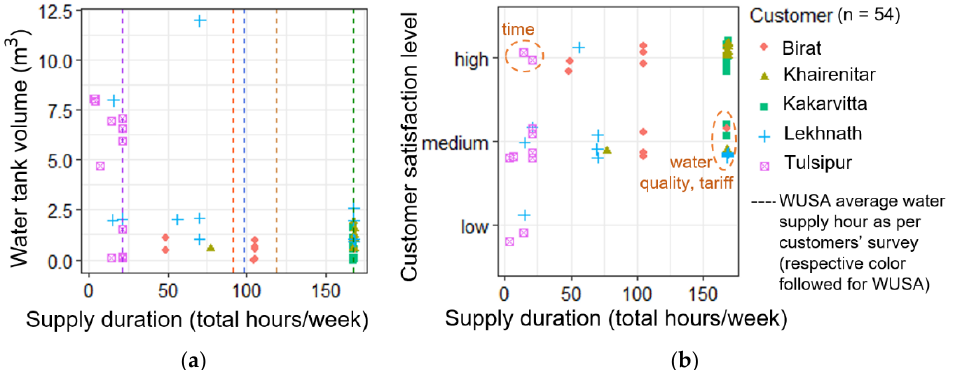
Figure 8. Water supply duration versus customers’ 1 : ( a ) water storage tank volume and ( b ) satisfaction level. 1 Each dot (shape) represents a response, and the dots are jittered to prevent overlapped plotting.